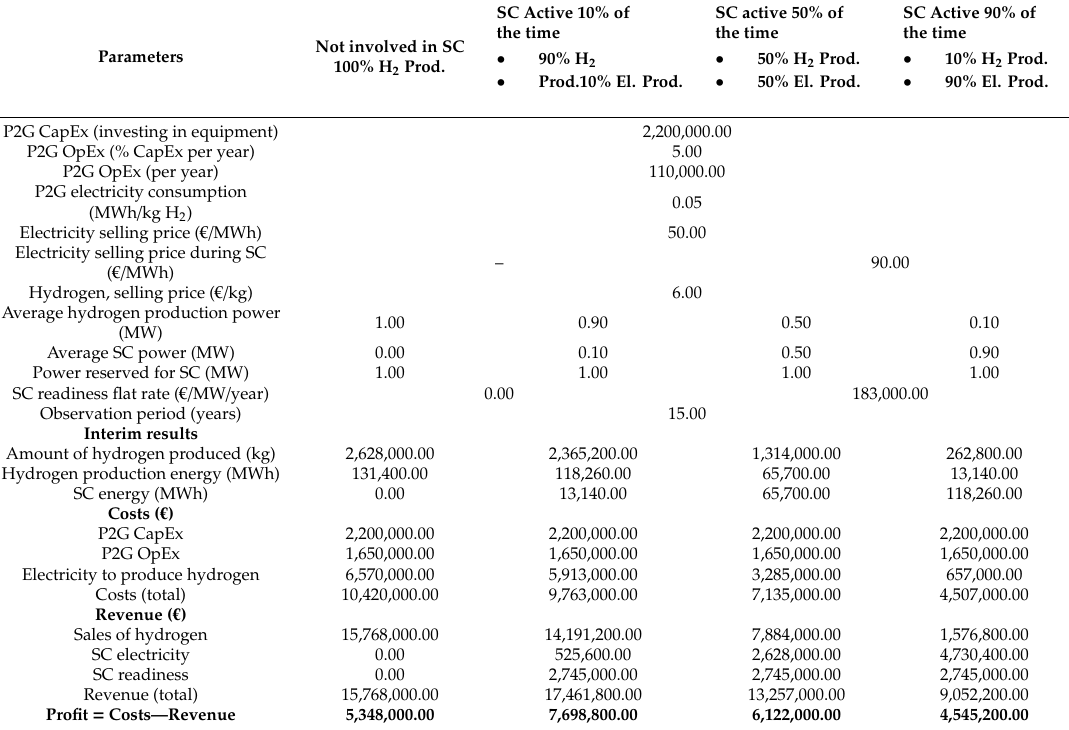
Table 6. Financial e ff ects of HPP with integrated P2G system and active SC 1 .